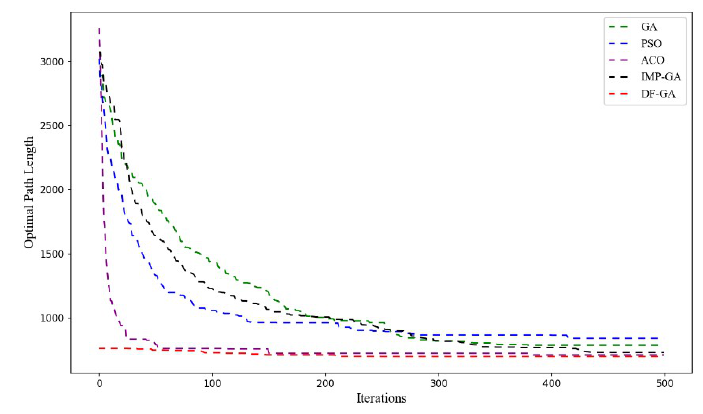
Figure 3. Convergence curve. Table 1. The performance of different algorithms on the st70